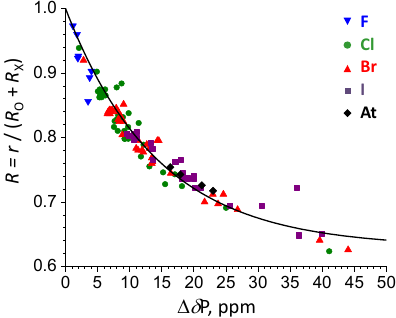
Figure 9. Correlation between the normalized distance parameter R = r / ( R O + R X ), where r is X ··· O distance and R O and R X are van der Waals radii of oxygen and halogen atoms, respectively, and the 31 P NMR chemical shift upon complexation, ∆ δ P, for R–X ··· O = PMe 3 halogen-bonded complexes studied in this work (X = F, Cl, Br, I, At). The solid line corresponds to Equation (9). R 2 (coefficient of determination) of the fitted curve equals to 0.933.